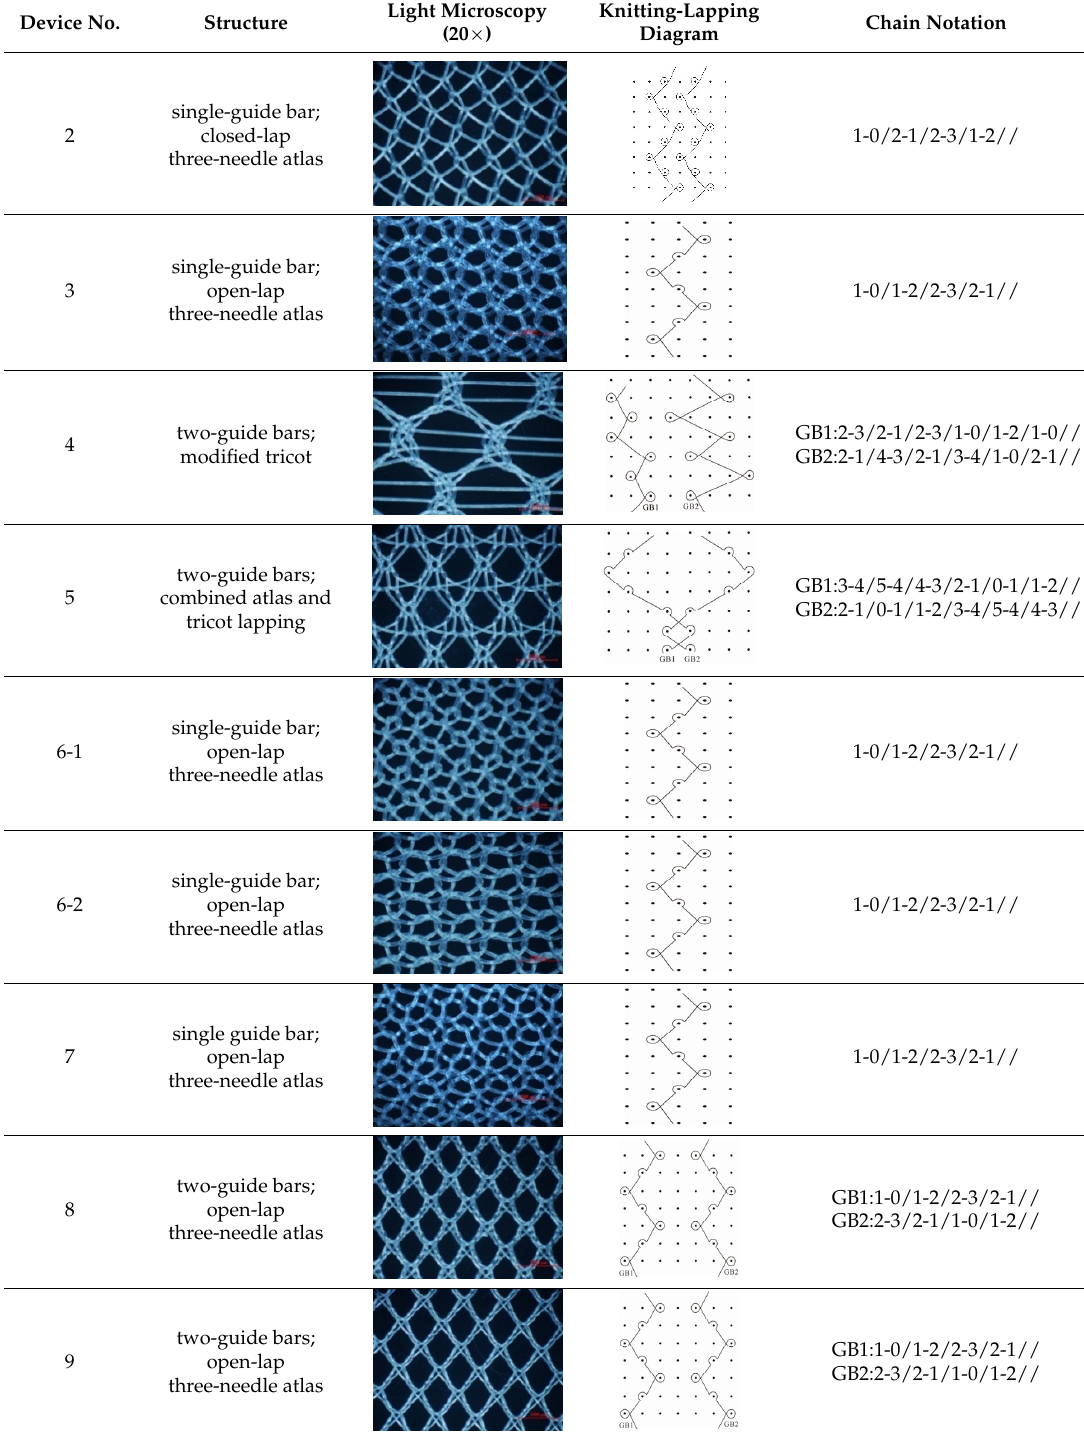
Table 2. Cont . Table 2. Loop structures and knitting ‐ lapping